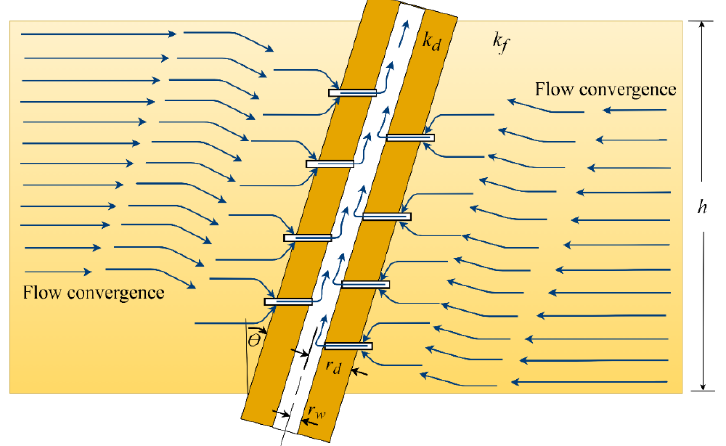
Figure 3. Schematic of inclined and completely perforated well with perforations parallel to radial flow direction and formation